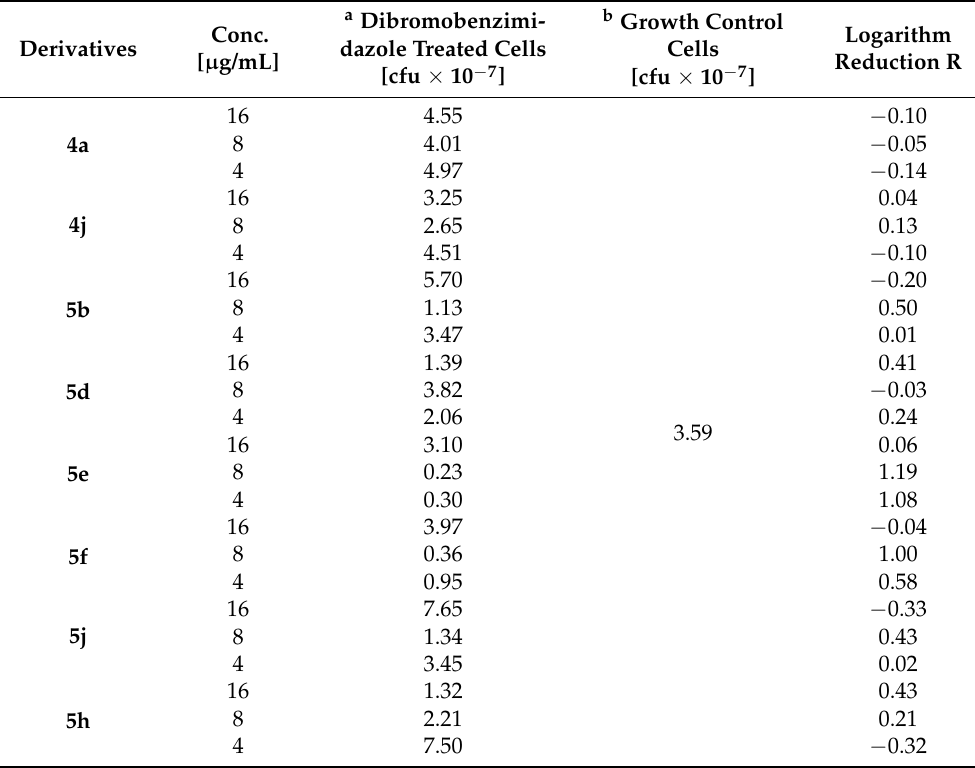
Table 3. Logarithmic cell growth reduction factor (R) of C. albicans ATCC SC5314. Conc. Derivatives